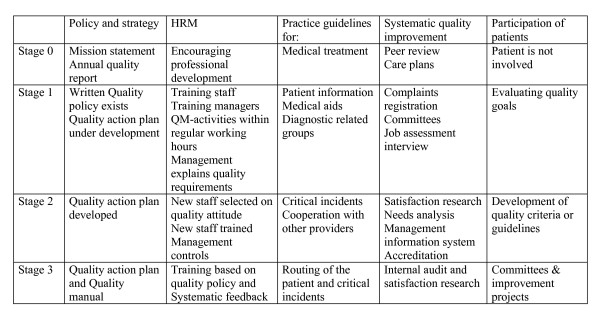
QM-activities divided into five focal areas and four developmental stages